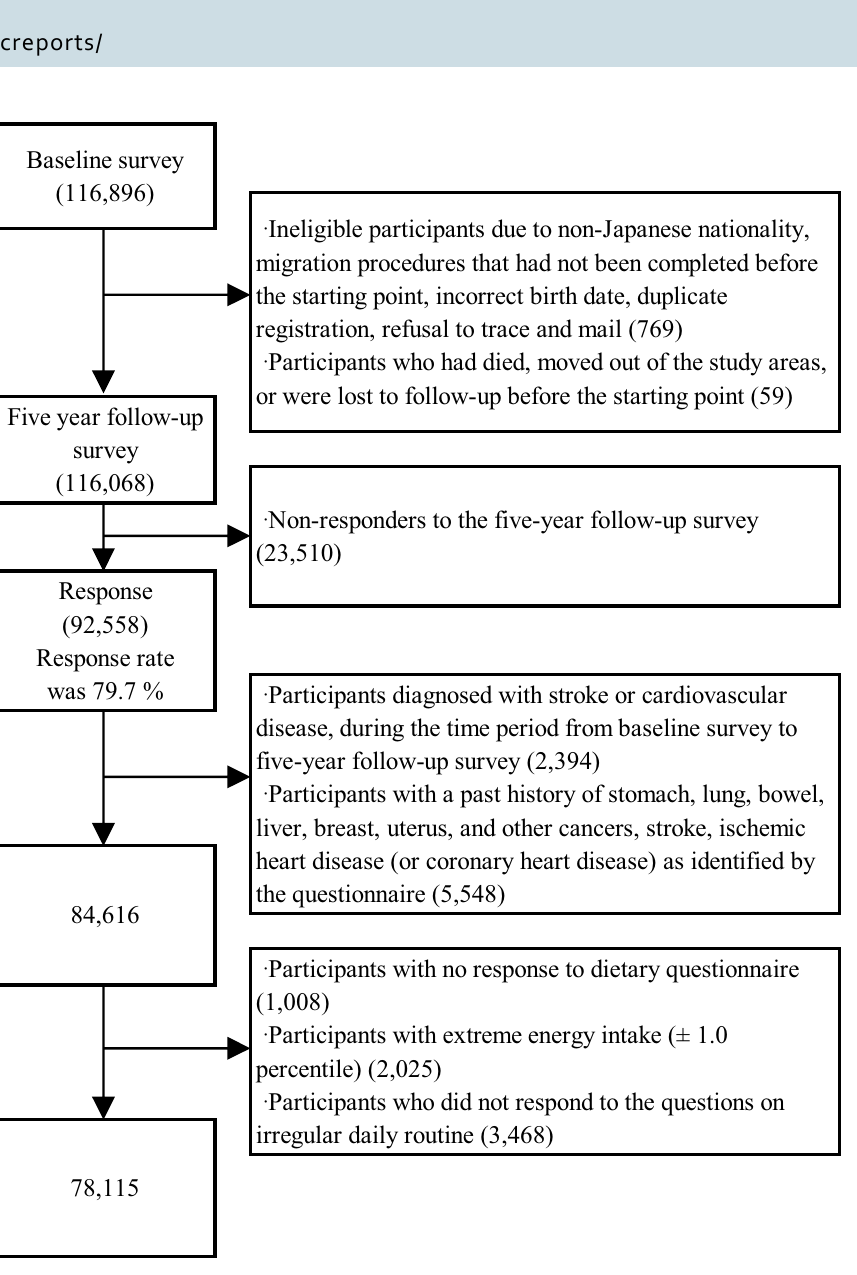
Figure 1. Flowchart of study